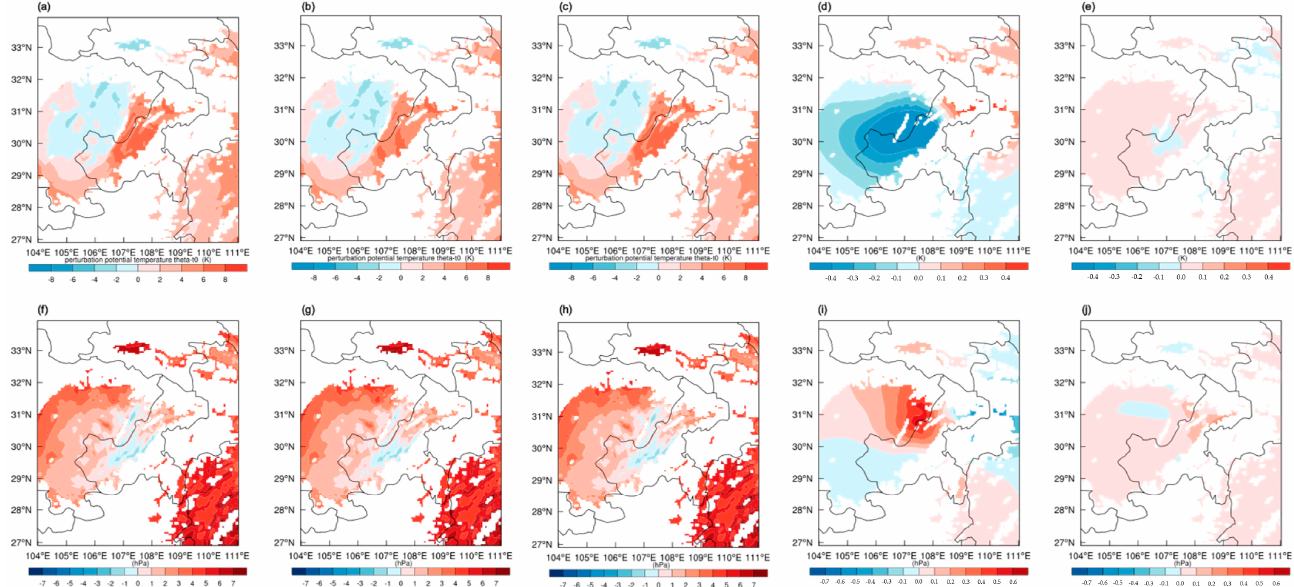
Figure 11. The perturbation potential ( a – e ) and perturbation pressure ( f – j ) from CTRL ( a , f ), ψ − χ ( b , g ), U − V ( c , h ), ψ − χ minus CTRL ( d , i ) and U − V minus CTRL ( e , j ) at 925 hPa at 2100 UTC 4 June